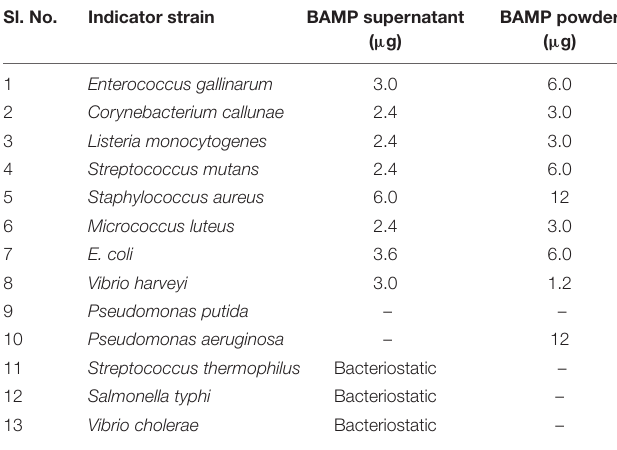
TABLE 3B | MIC of BAMP supernatant and spray dried powder (concentration in micrograms). Sl. No.